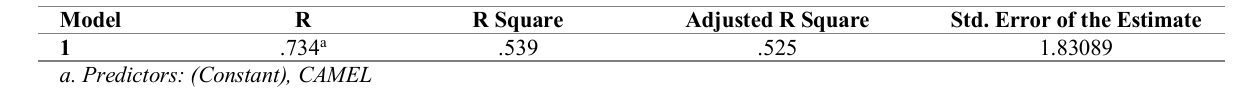
Table 8: Regression Model Summary